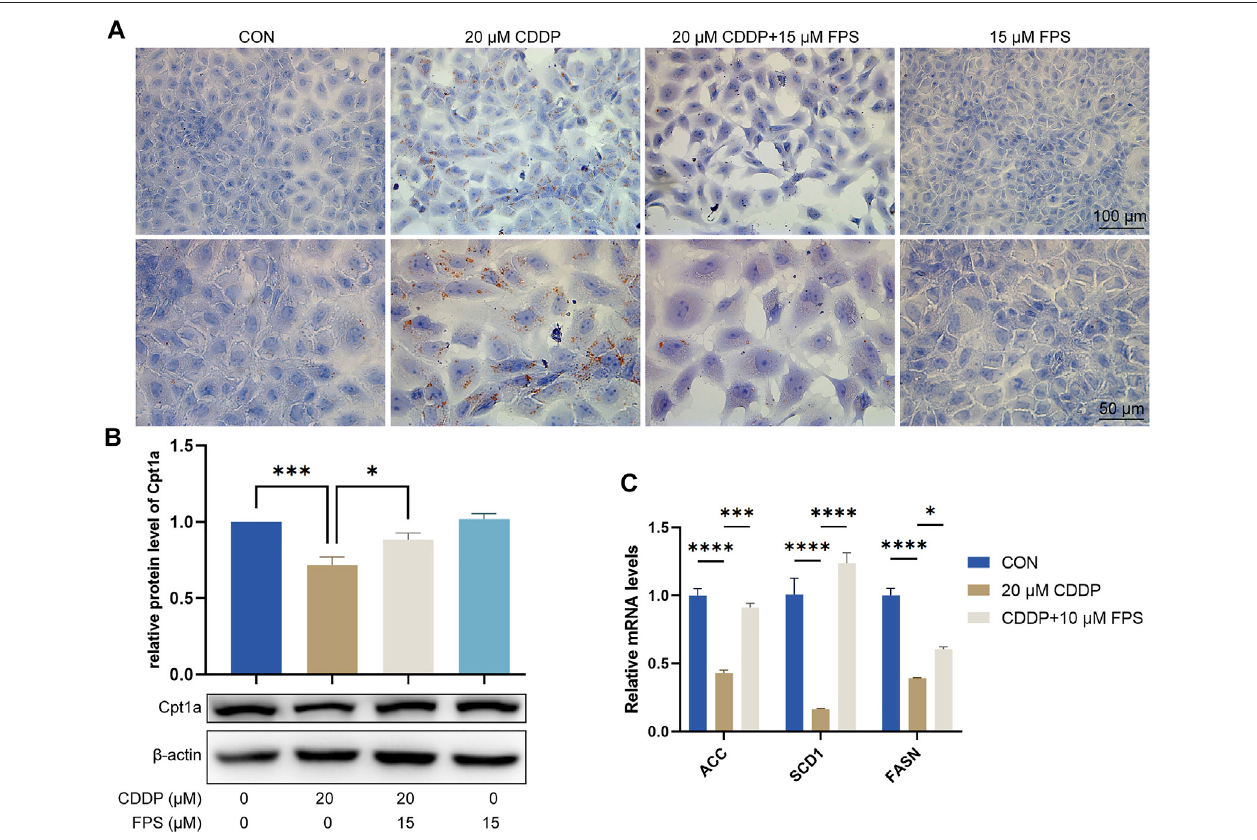
FIGURE 7 | FPS-ZM1 diminished cisplatin-induced renal lipid accumulation and FAO impairment. (A) Photomicrographs illustrated lipid deposition in NRK-52E cells by using Oil red O staining. (B) Protein expression pro fi ling of Cpt1a by western blot. One-way ANOVA was used to compare means between groups. (C) The mRNA levels of fatty acid synthesis-related genes ACC, SCD1, and FASN determined by qPCR. Two-way ANOVA was used to compare means between groups. Data are expressed as mean ± SEM. Scale bar: 100 or 50 μ m as indicated in the fi gure. * p < 0.05, *** p < 0.001, **** p <